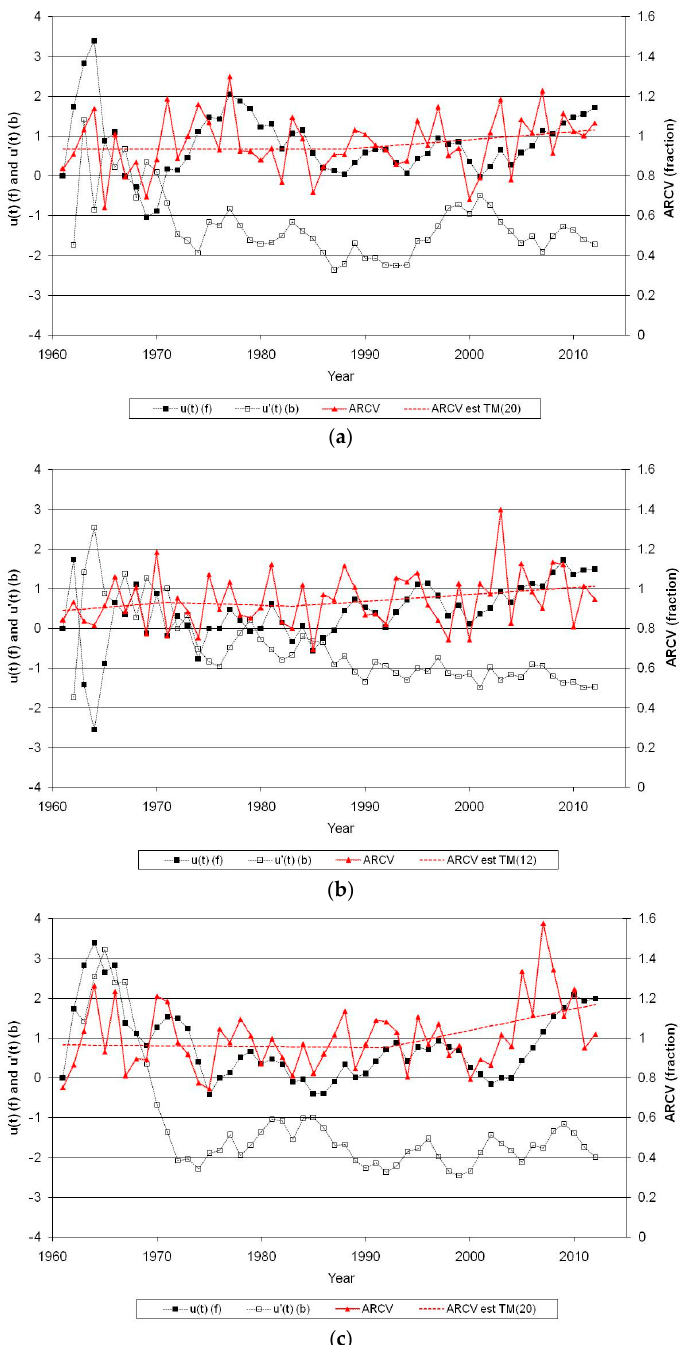
Figure 8. Variation coefficient of total annual rainfall (ARCV) at PI ( a ), RC ( b ) and VM ( c ) between 1960 and 2012, and determination of the breakpoint from Mann–Kendall–Sneyers, where u(t) and u’(t) are forward (f) and backward (b) test values, respectively, and from Tomé–Miranda (TM), where MINIX = 20 for ( a ) and ( c ) and 12 for ( b ).